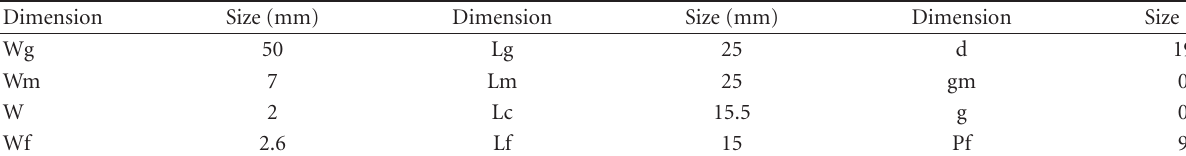
Table 1: Antenna dimensions.